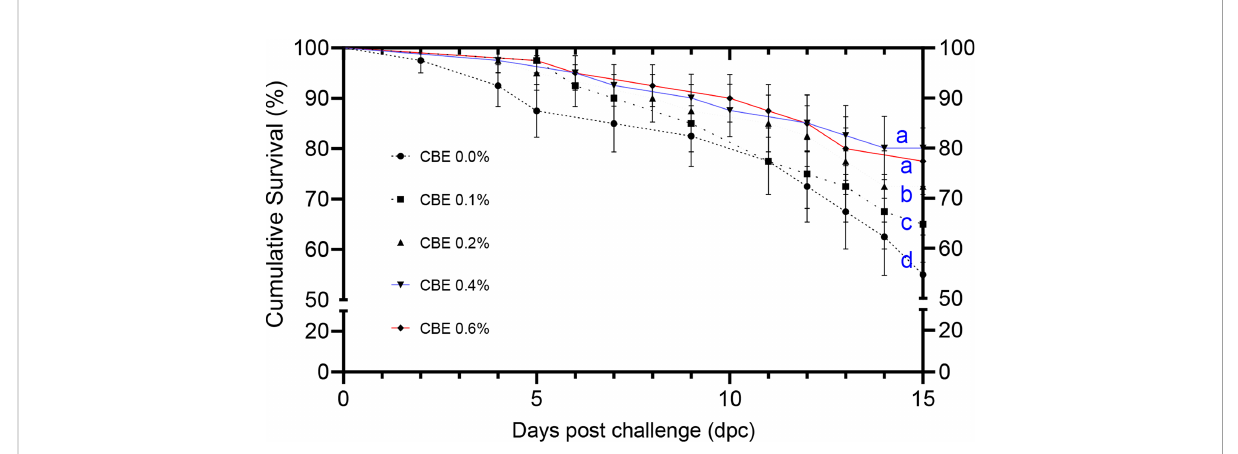
FIGURE 1 The cumulative survival analysis in Nile tilapia groups fed different doses of CBE along 2 weeks post challenge with Aeromonas hydrophila , represented by Kaplan – Meier regression curves. Signi fi cance letters (a, b, c, and d) demonstrate the signi fi cantly different survival percent (p < 0.05) at the end of the challenge trial.